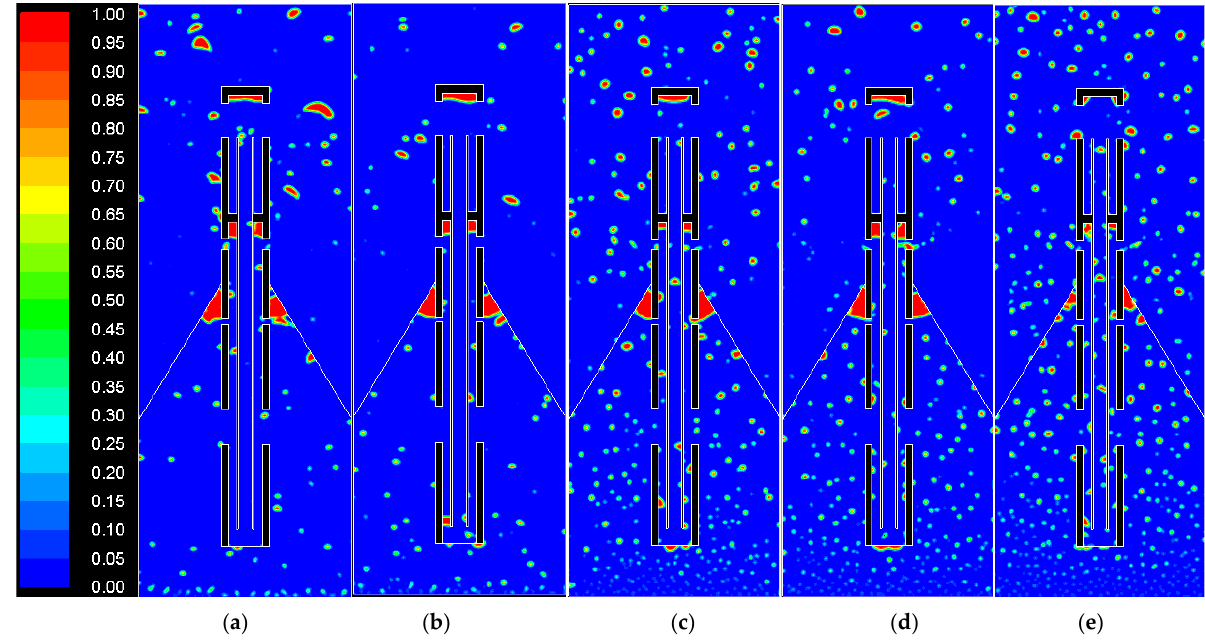
Figure 6. Cloud diagram of gas phase distribution of gas – oil – water with total flow at ( a ) 20 m 3 /d; ( b ) 30 m 3 /d; ( c ) 40 m 3 /d; ( d ) 50 m 3 /d; ( e ) 60 m 3 /d. Figure 7 is a cloud diagram of oil phase distribution under different flow rates. Red represents the oil phase and blue represents the water phase. Due to the low oil content,